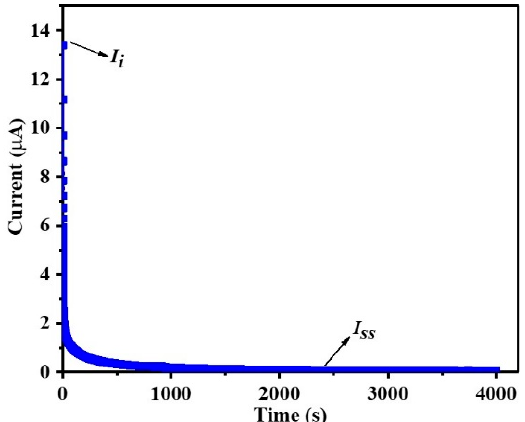
Figure 5. The polarization plot of the current versus the time of the MCIGPE −